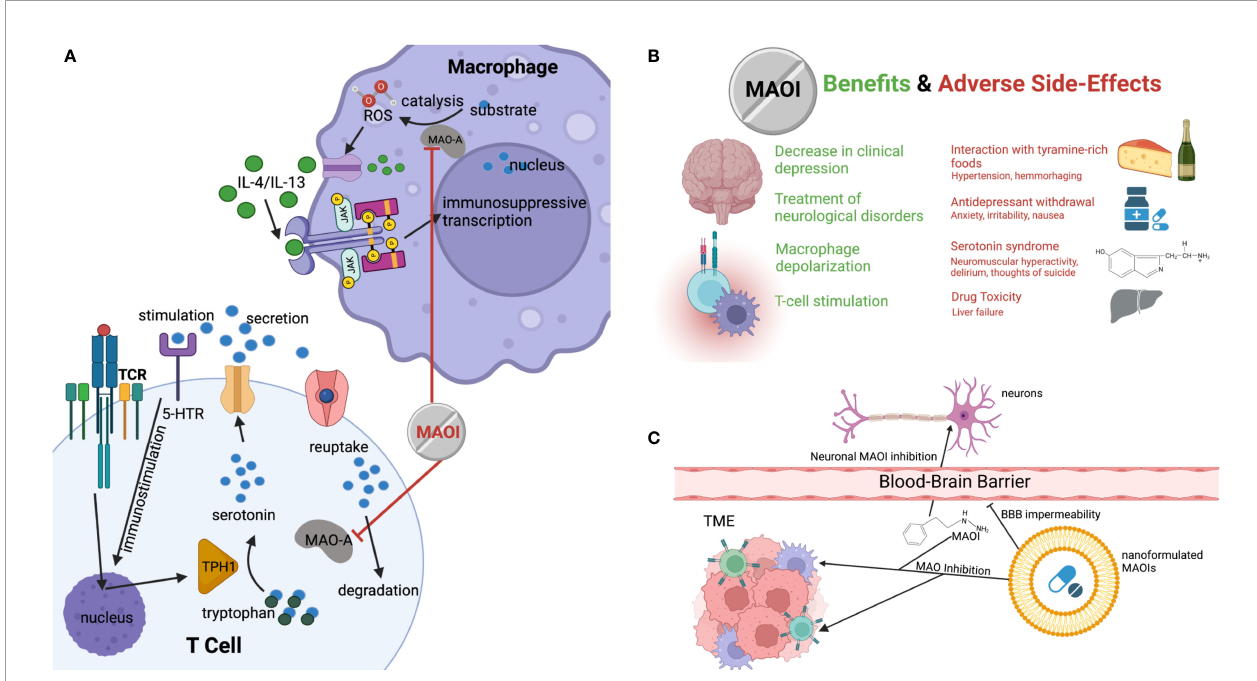
FIGURE 1 | The potential of MAOI as a next-generation ICB therapy. (A) Diagram demonstrating how MAOIs inhibit MAO-A activity in immune cells, increasing free, immunostimulatory serotonin for intratumoral CD8 T cell stimulation and decreasing immunosuppression-inducing ROS produced by MAO-A oxidation of monoamine substrates in TAMs. (B) Current and potential clinical therapeutic bene fi ts of MAOIs and the known associated side effects and symptoms. (C) Demonstration of nanoformulation of MAOIs preventing administered drugs from crossing the blood-brain barrier while maintaining ability to deliver drugs to target cells in tumor, avoiding the systemic application of the drug and mitigating side